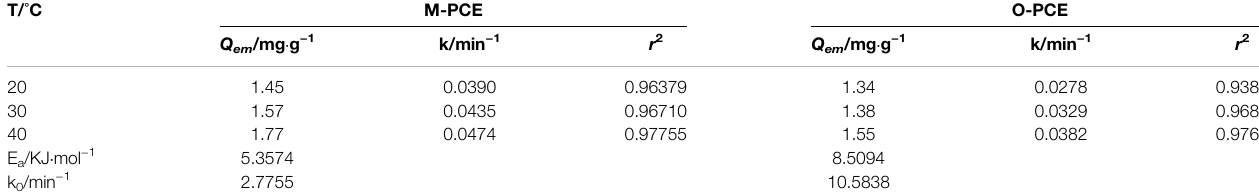
TABLE 6 | Fitted values of Lageren adsorption rate equation derived from polycarboxylate at cement particles surfaces. T/ ° C